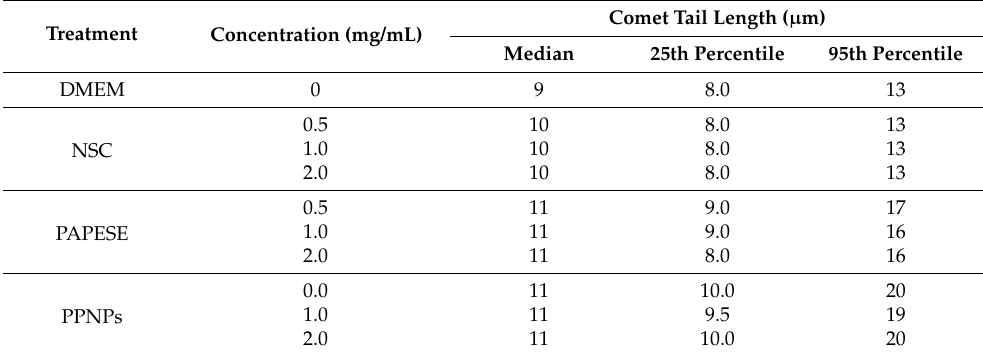
Table 3. Comet tail length of human ventricular cardiomyocytes exposed to PAPESE, NSC, and PPNPs.